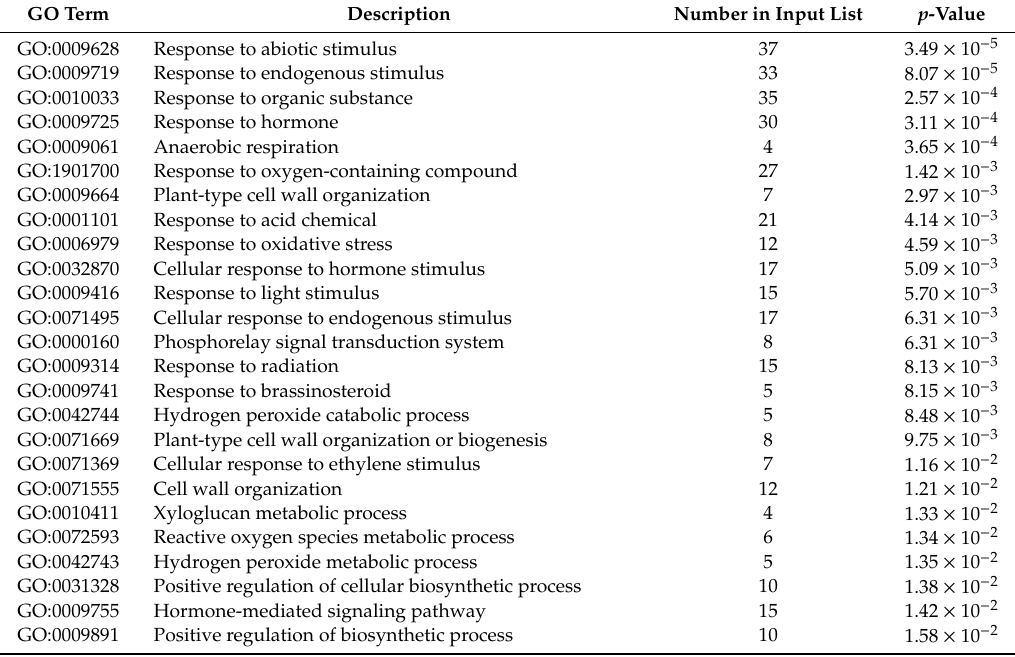
Table 4. List of GO terms of genes downregulated more than 2-fold in HRE1 β